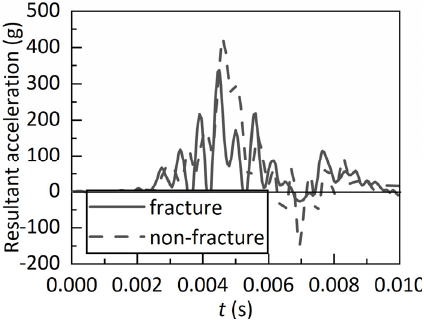
Figure 9. Comparison of resultant acceleration (filter of 1000 Hz) with parietal impact contrecoup side between fracture and non-fracture models at 35 km/h.